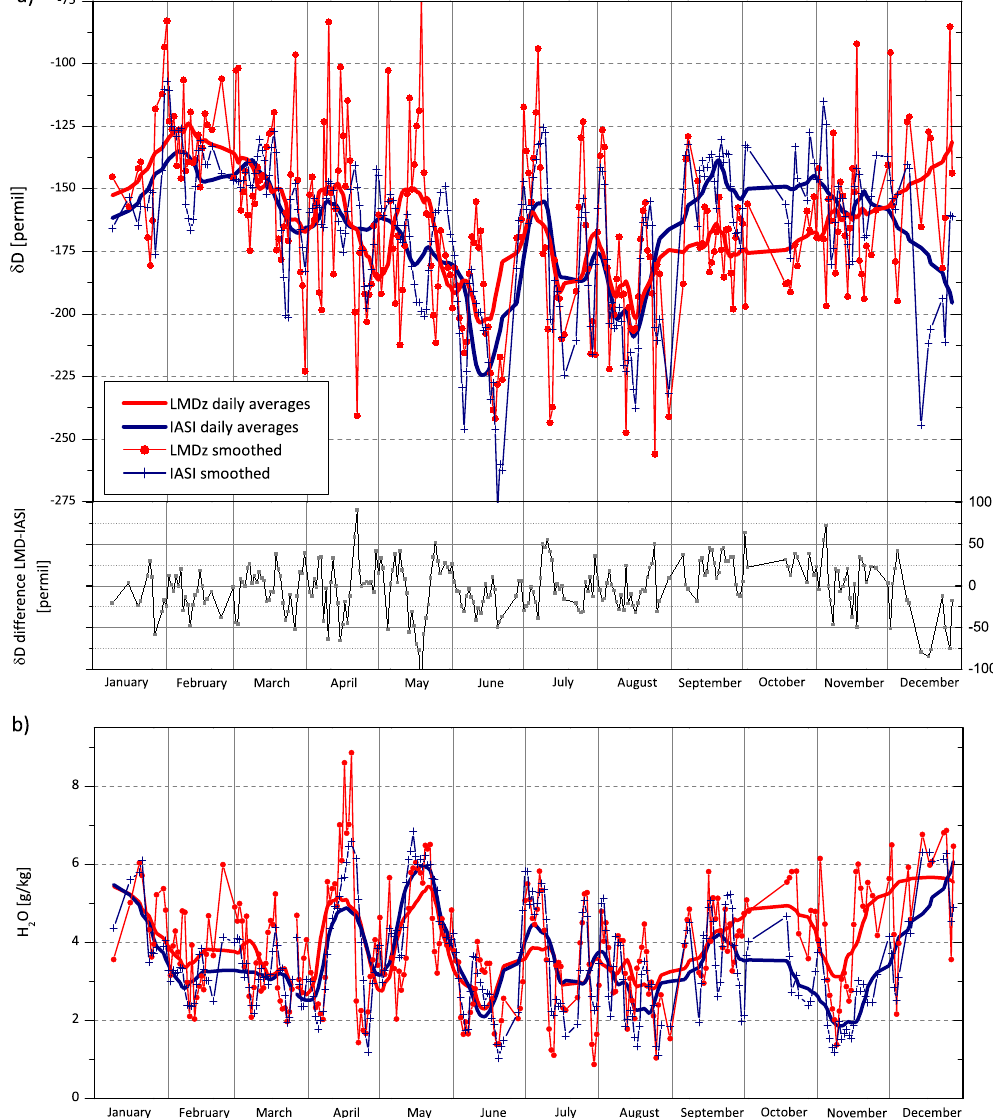
Fig. 7. Time series at the Darwin site for the year 2010 for the 3–6km layer. (a) Top pannel: IASI δ D daily averages (red circles and line) are compared to corresponding LMDz-iso simulations (blue crosses and line). A Savitzky-Golay smoothing filter has been applied (thick lines) to highlight seasonal and intra-seasonal pattern. (b) Same as (a) but for specific humidity in gkg − 1